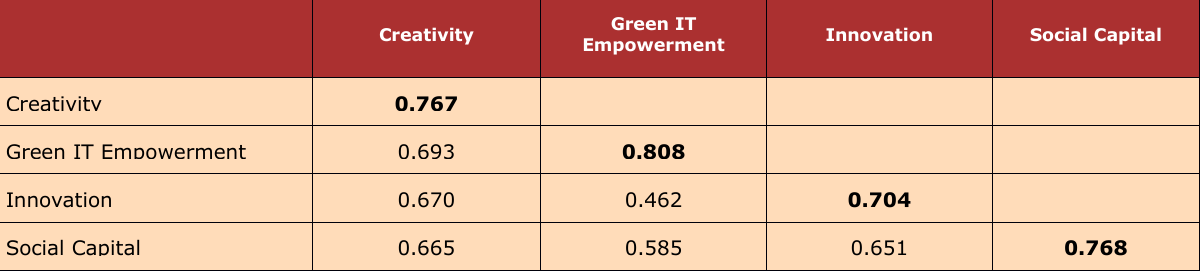
Table 4. Correlation of the square root of AVE